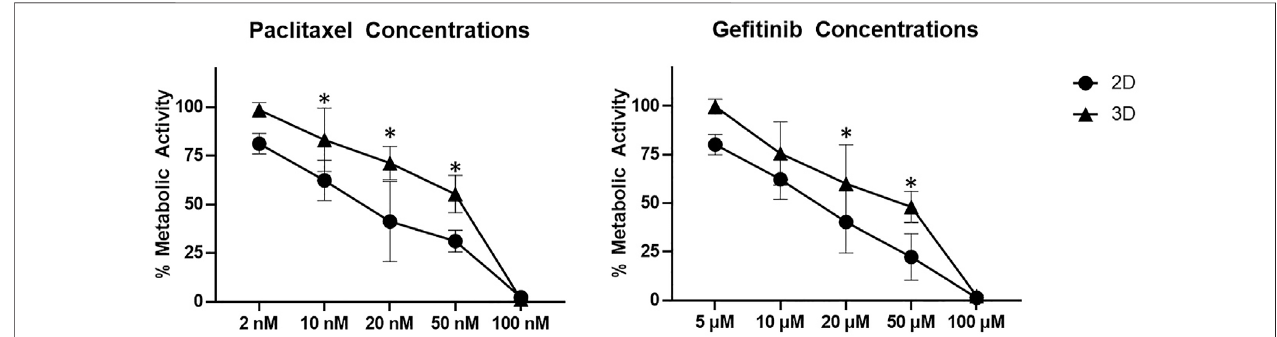
FIGURE 5| Meatbolic activity measured byan XTT-assay after treatment of2D and 3D Tri-cultures with different concentrations ofge fi tinib and paclitaxel for 72 h. Error bars show standard deviation. Statistical signi fi cance indicated by * shows signi fi cance ( p < 0.05) between mean values.